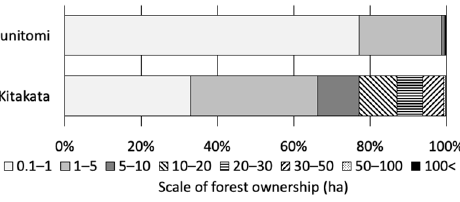
Figure 1. Study site.